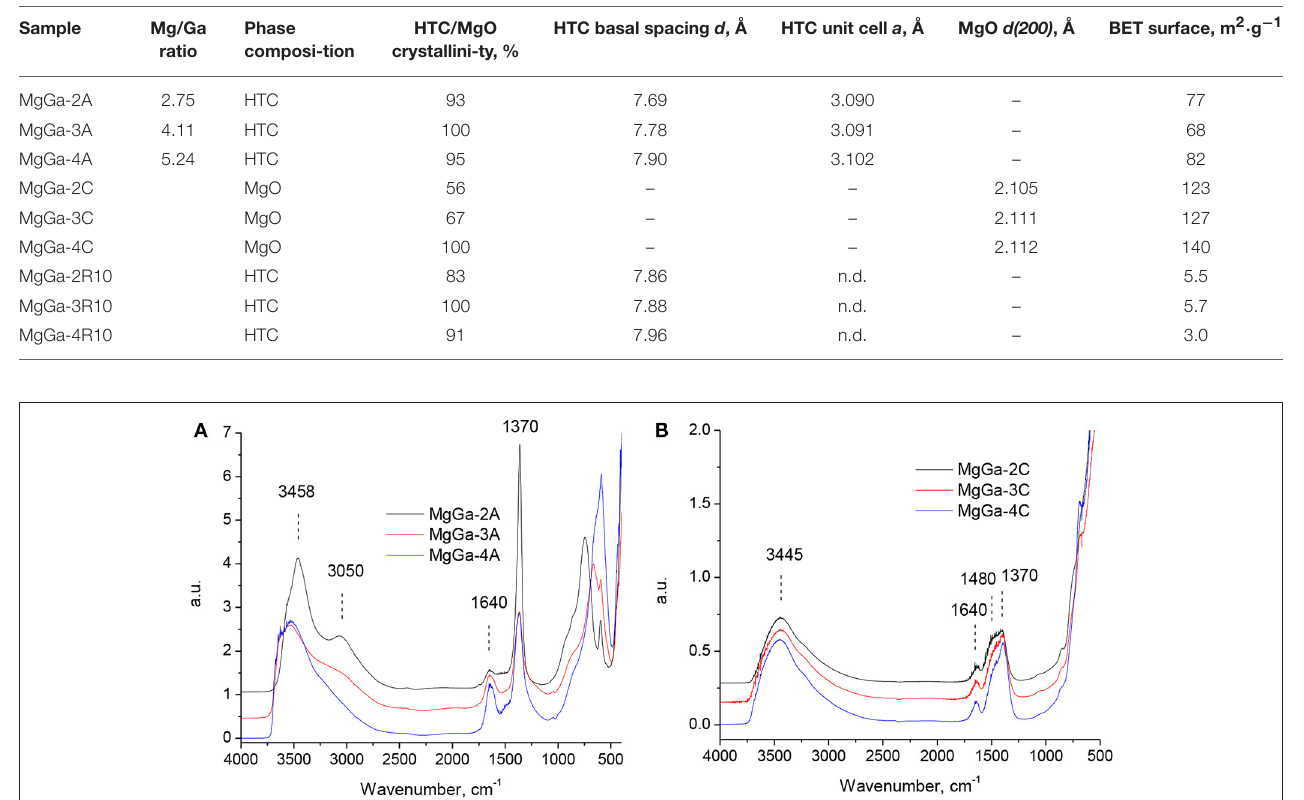
TABLE 1 | Phase composition and BET surface area of the as-prepared hydrotalcites.